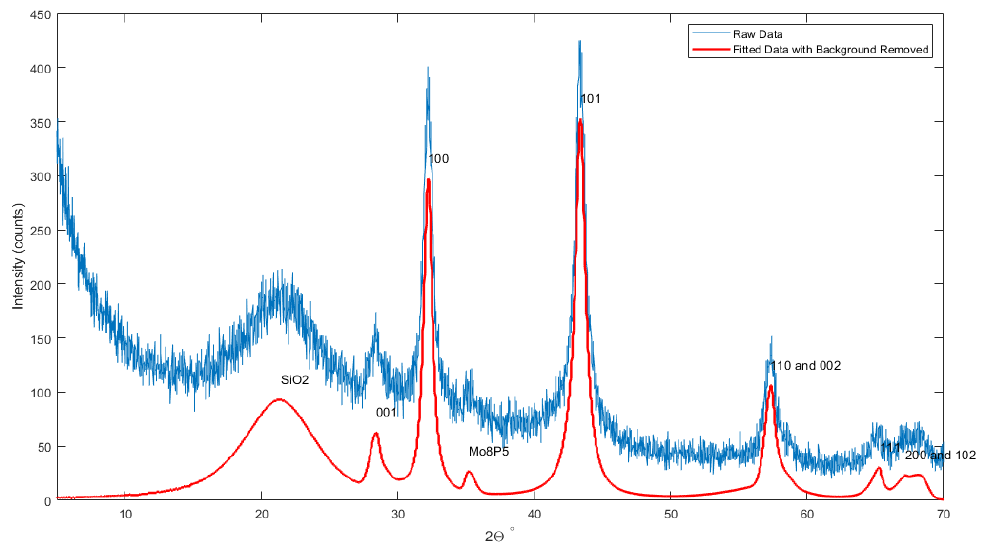
Figure 2. Grazing incidence XRD of MoP